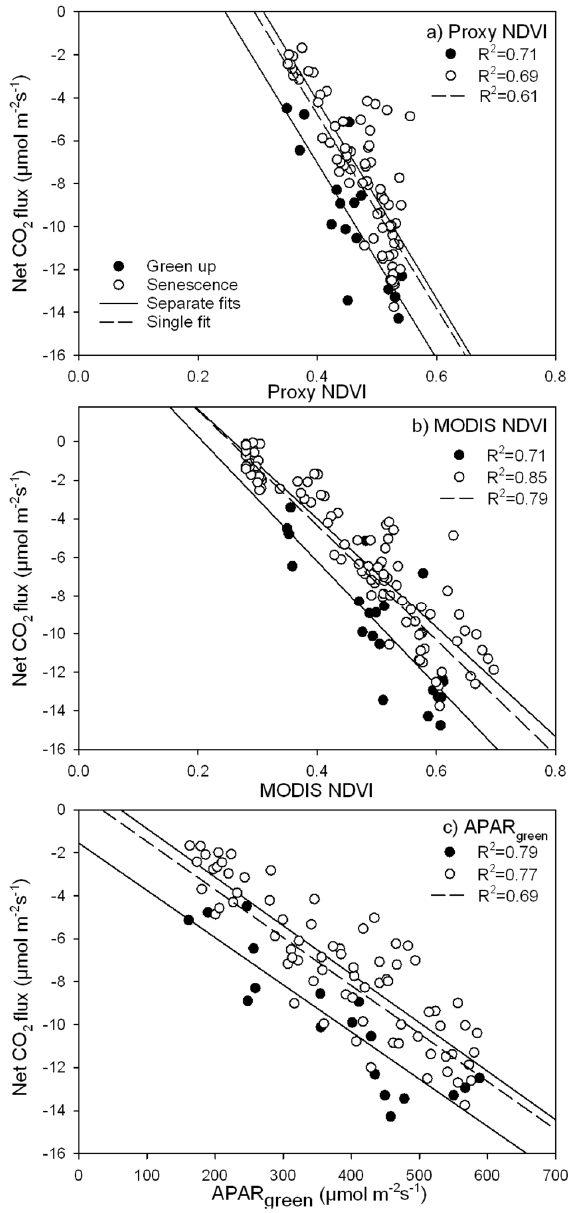
Figure 7. Relationship between proxy NDVI (5 h average, panel a ); MODIS NDVI (panel b ); APAR green (panel c ) and filtered net CO 2 fluxes (5 h average) for the E3 site in 2012. Fits are shown for the whole season (dashed line), for the green-up phase (black dots, solid line), and for the senescence phase (white dots, solid line). R 2 values are reported for each panel considering the whole season (dashed line), the green-up phase (black dots) and the senescence phase (white dots). p values are <0.001 for all the relationships.